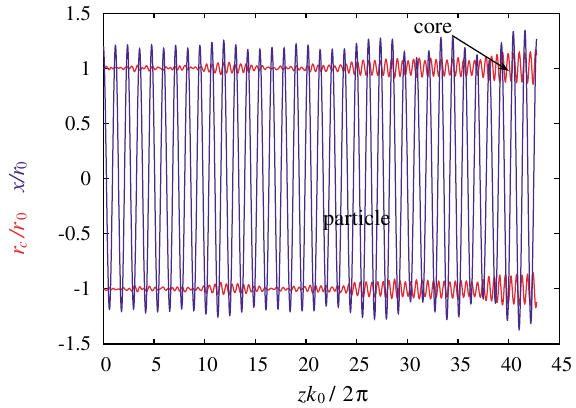
FIG. 4. (Color) Particle and core envelopes for a matched beam with 1% rms statistical focusing gradient errors (cid:3) 1 : 2 , (cid:18) (cid:3) 0 : 8 x (cid:4) 0 (cid:5) =r 0